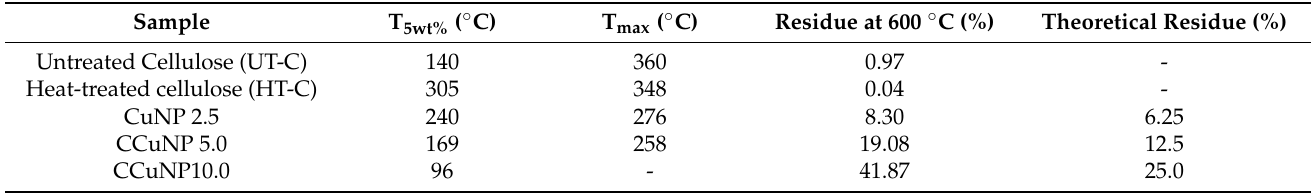
Table 2. Data of TGA and DGA for cellulose and